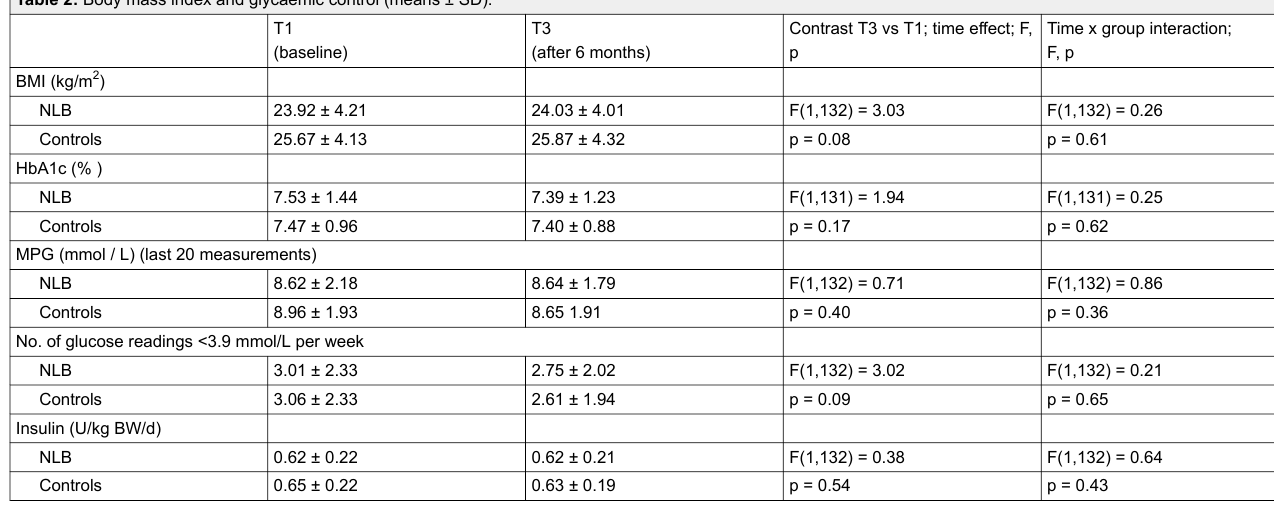
Table 3: Ability to estimate carbohydrates (difference between estimated and real carbohydrate content of dummies in gr; means ± SD). T1